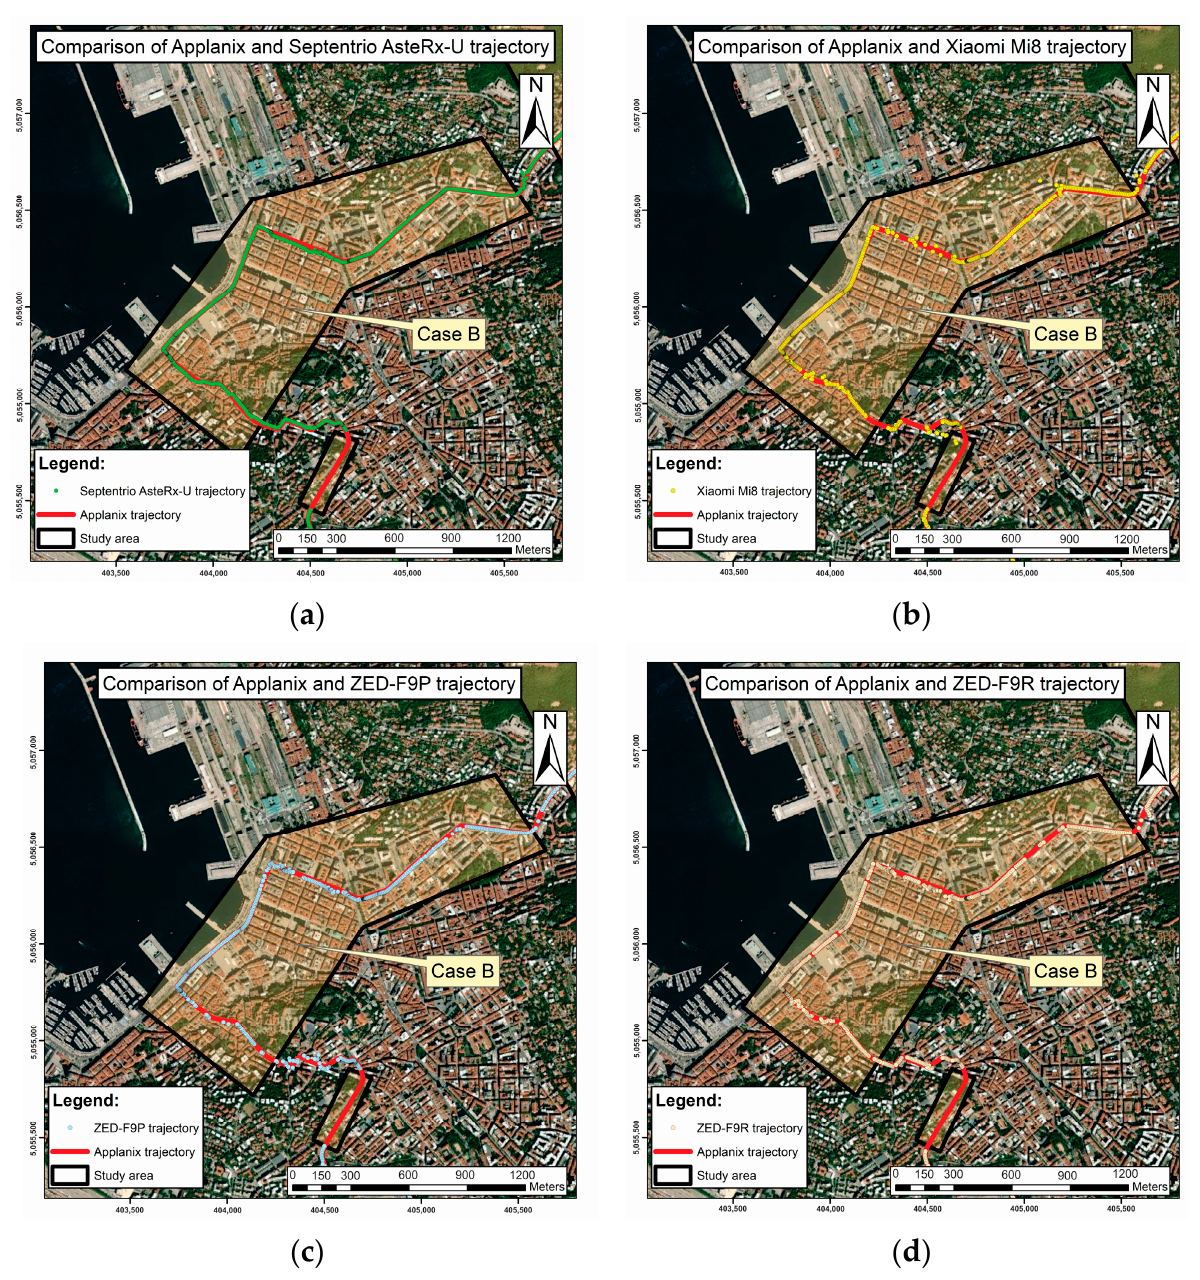
Figure 11. Case B: performance of: ( a ) Septentrio AsteRx-U, ( b ) Xiaomi Mi8, ( c ) u-blox ZED-F9P, and ( d ) u-blox ZED-F9R. Table 9. GPS solutions, solutions with fixed ambiguities, and deviation of distances below the given threshold. Situation: Case B—urban area (no. of total solutions: 700).